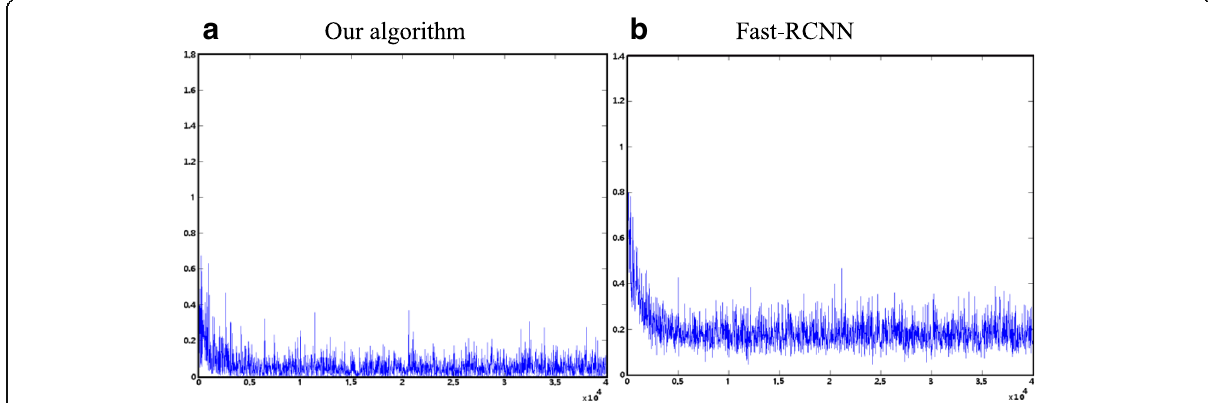
Fig. 7 Loss chart. a Our algorithm. b